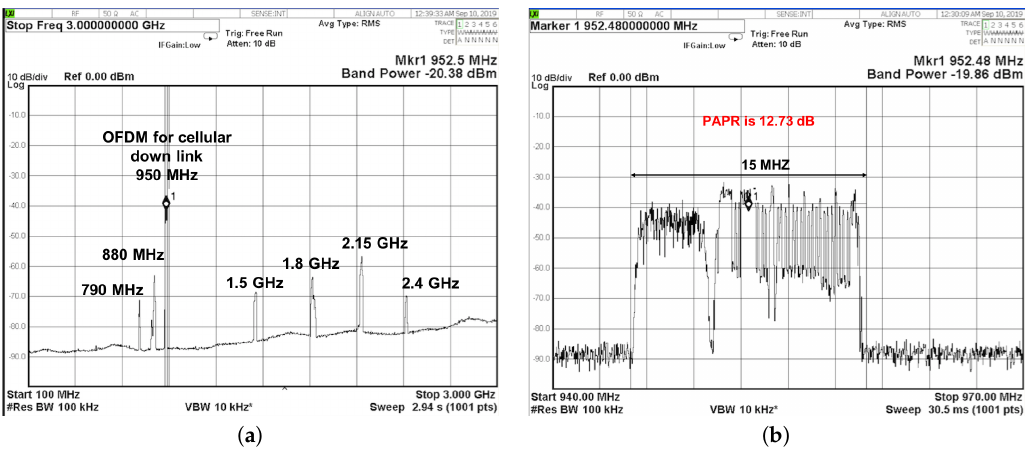
Figure 1. Measured spectrum of RF signals at the measurement position: ( a ) Spectrum of RF signals and ( b ) Magnified spectrum of the 952 MHz signal.